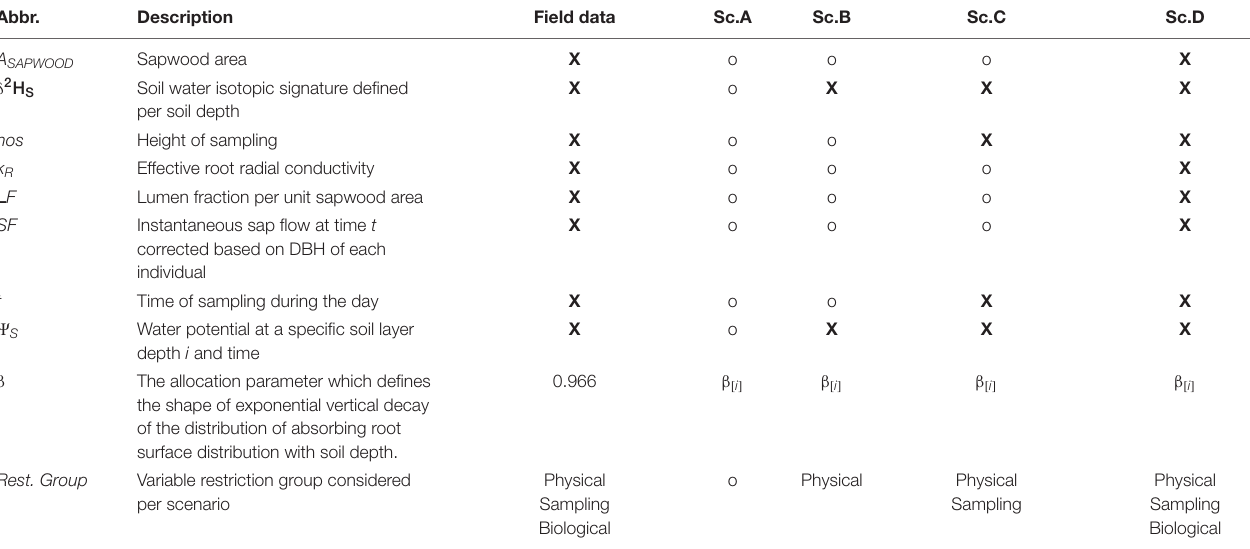
TABLE 1 | Overview of the variable restrictions (X: restricted; o: non-restricted) considered within the inverse SWIFT procedure to simulate synthetic field data and corresponding conditional density probability distributions P( δ xyl | β , χ ) .